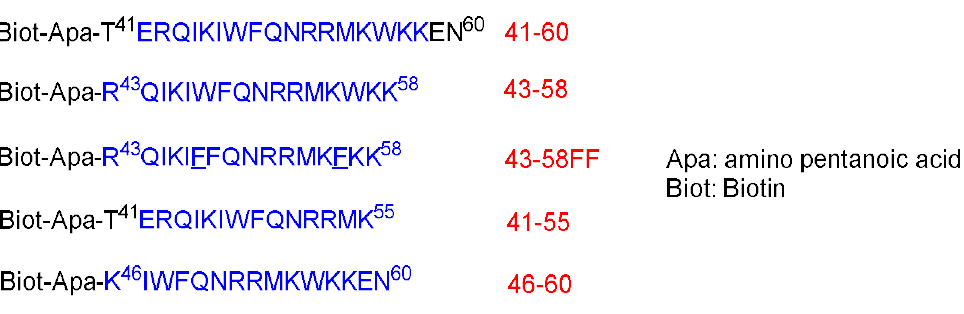
Figure 3. Different sequences. The region that corresponds to the third helix of the homeodomain is shown in blue. The two new F residues that replaced the W are underlined.